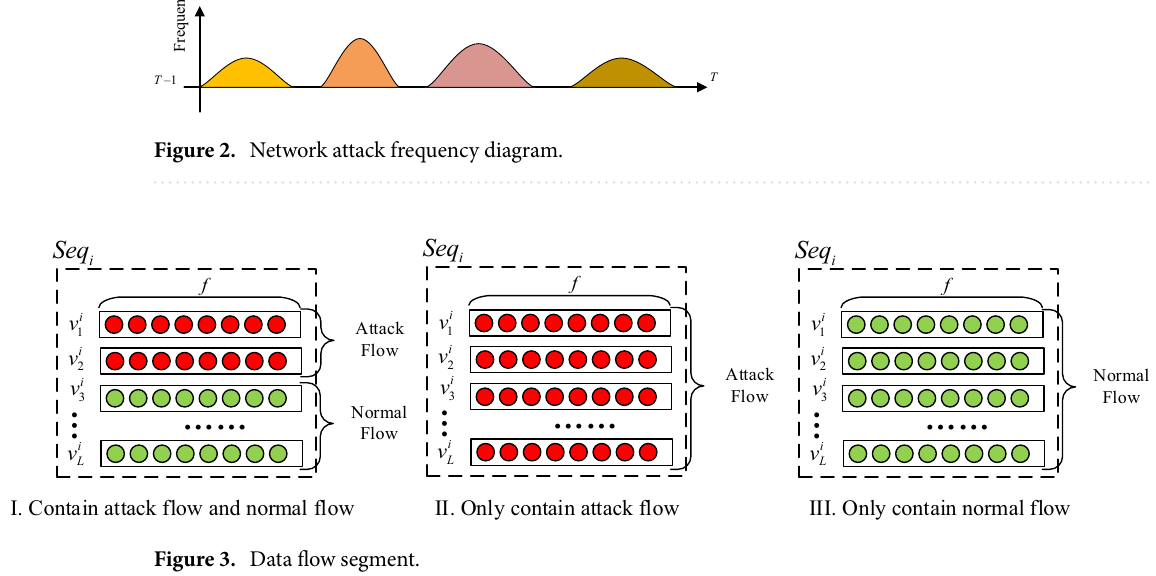
Figure 3. Data flow